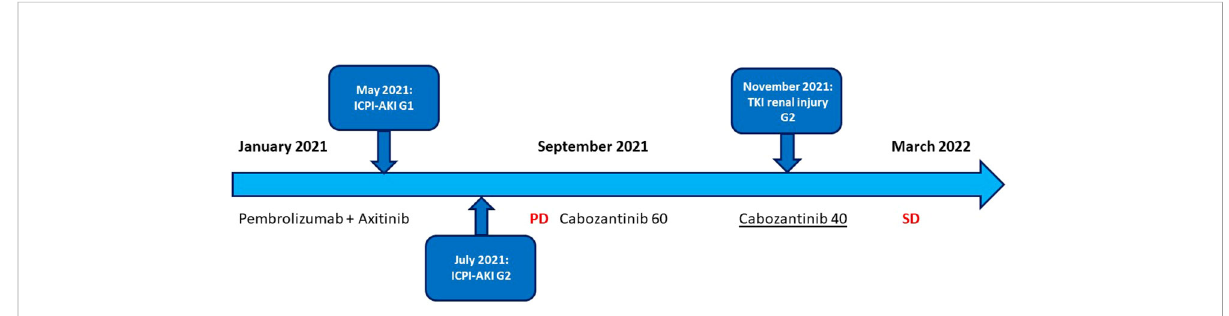
FIGURE 3 Timeline management of nephrological toxicity in course of ICI- and TKI-based